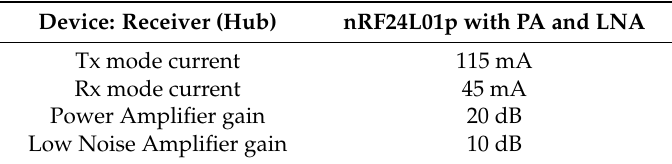
Table 4. Features of nRF24L01p receiver [15].